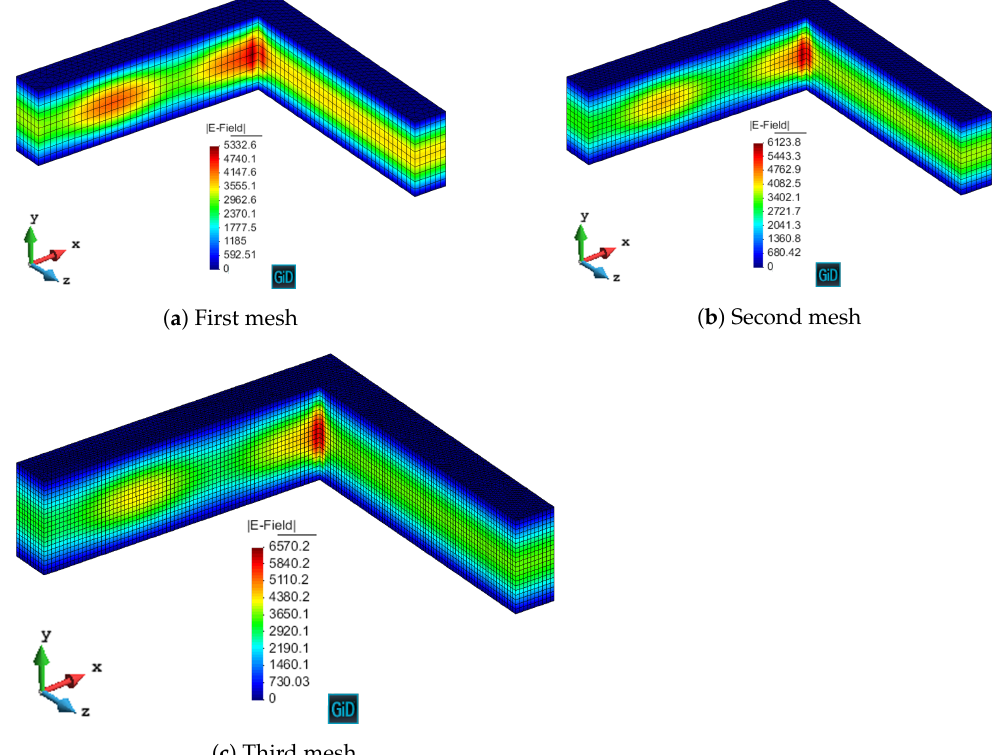
Figure 22. Evolution of the electric field for uniform refinement in an L-shaped